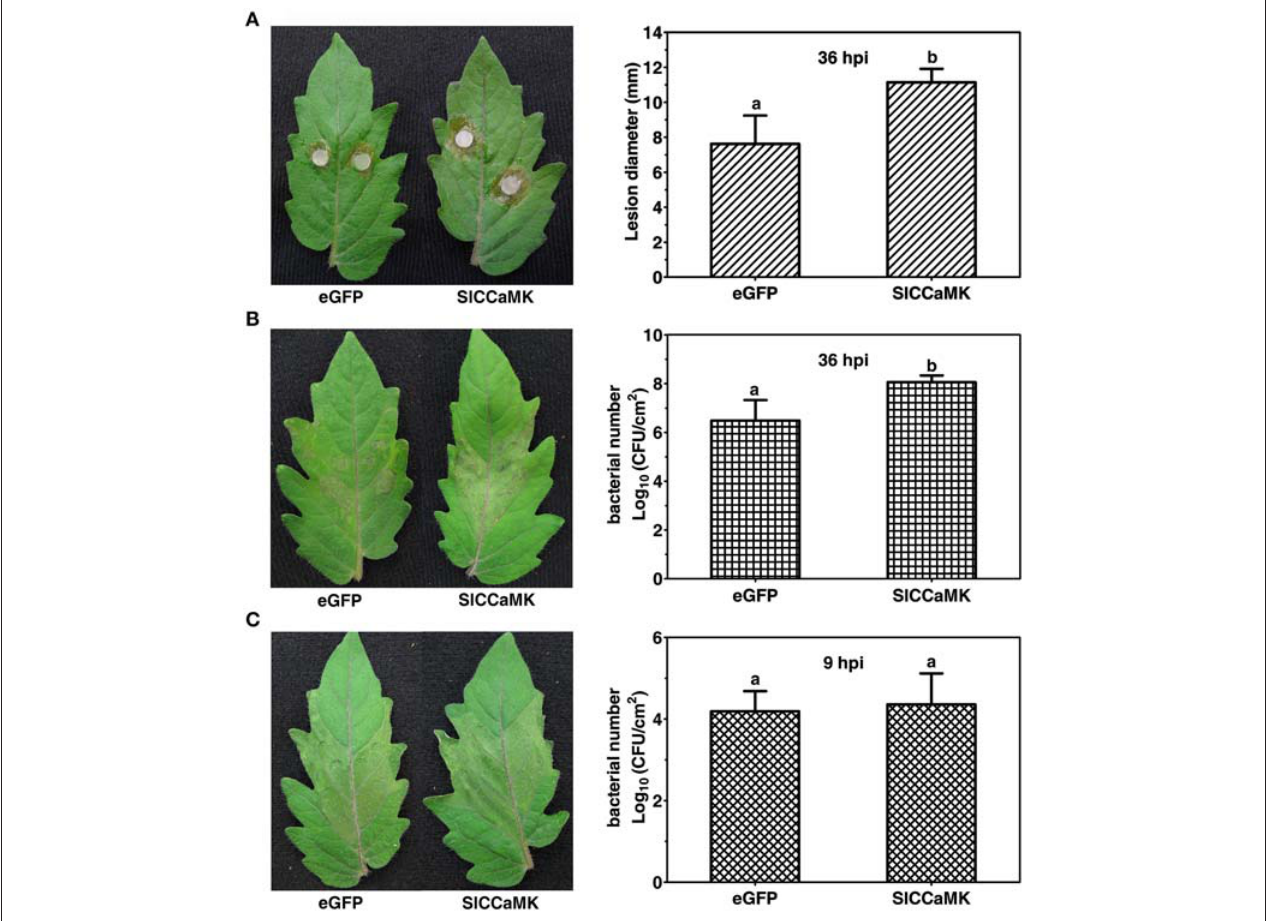
FIGURE 6 | Knock-down of the SlCCaMK gene by VIGS decreased the tomato disease resistance. (A) The necrosis symptoms caused by S. sclerotiorum inoculation and statistical analysis of lesion diameter at 36hpi. (B) The necrosis symptoms caused by Pst DC3000 infiltration and bacterial number in the infiltrated areas at 36hpi. (C) The HR symptoms caused by Xoo infiltration and bacterial number in the infiltrated areas at 9hpi. Significant differences of bacterial number and lesion diameter are indicated as different lowercase letters ( P ≤ 0.05, by Student’s t